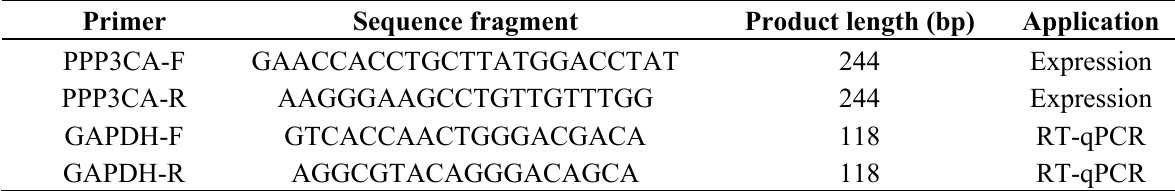
Table 1. Primer pairs used for analysis of the gene expression of Tianfu goat PPP3CA .